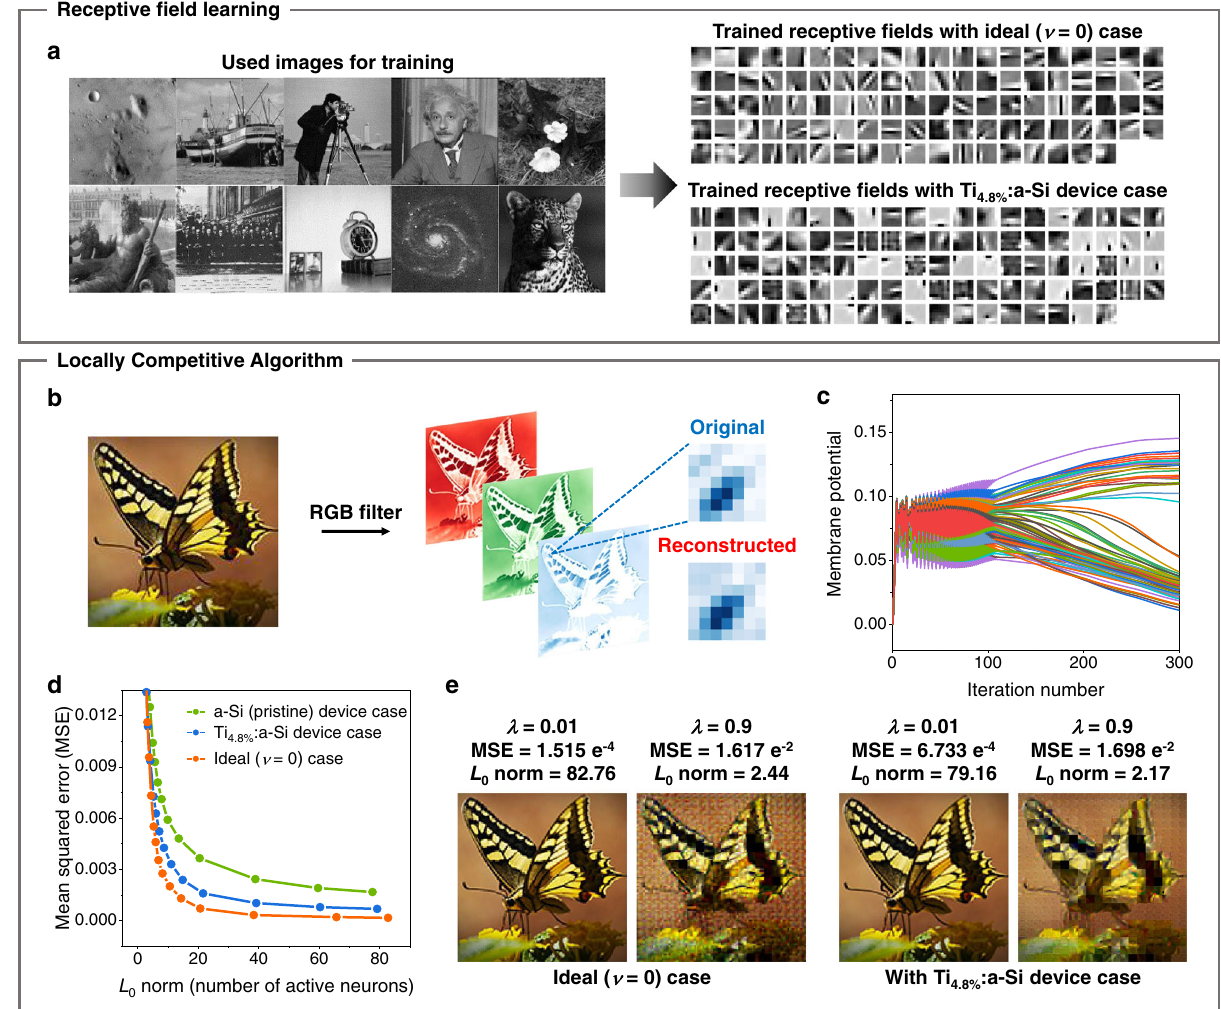
Fig. 5 Feature extraction task of sparse coding simulation using the measured device characteristics. a Receptive fi eld trained through the stochastic gradient descent (SGD) and locally competitive algorithm (LCA) after 50 iterations. Ten natural images are used for training receptive fi elds (left). Trained features, similar to Garbor fi lters, are shown for the ideal ( ν = 0) case and the Ti 4.8% :a-Si device case. b The original natural colour image (140× 140 resolution image) passed to a red-green-blue (RGB) fi lter to be encoded and reconstructed through the LCA. After reconstruction, each RGB patch image is combined to a natural colour image. c Membrane potential of output neurons during iterations. d Reconstruction mean squared error (MSE) of each memristor device case in different sparsity ( L 0 norm). e Reconstructed images after sparse coding simulation for the ideal case and the Ti 4.8% :a-Si device case with threshold, λ = 0.01/0.9, and resultant L 0